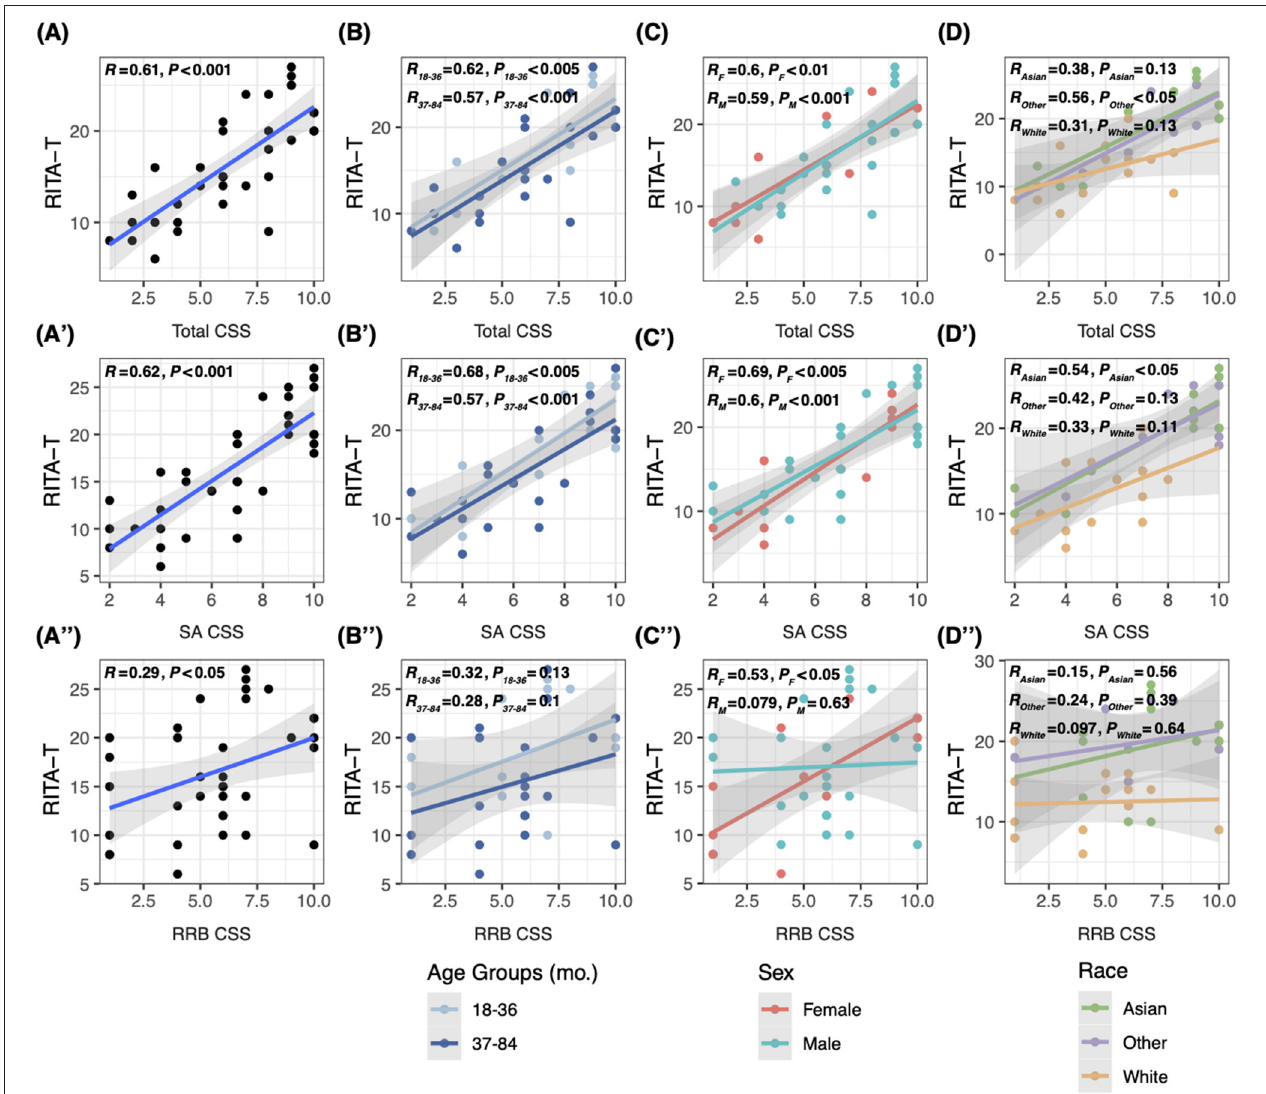
FIGURE 1 | Linear regression model comparing correlations between RITA-T score and ADOS-2 CSS, total and sub-scores. (A–A ′′ ) Correlations between scores of the RITA-T and ADOS-2 total CSS, SA CSS and RRB CSS in all subjects; (B–B ′′ ) correlations between scores of the RITA-T and ADOS-2 in 18–36 and 37–84 month age subgroups; (C–C ′′ ) correlations between scores of the RITA-T and ADOS-2 in male and female sex subgroups; (D–D ′′ ) correlations between scores of the RITA-T and ADOS-2 in race